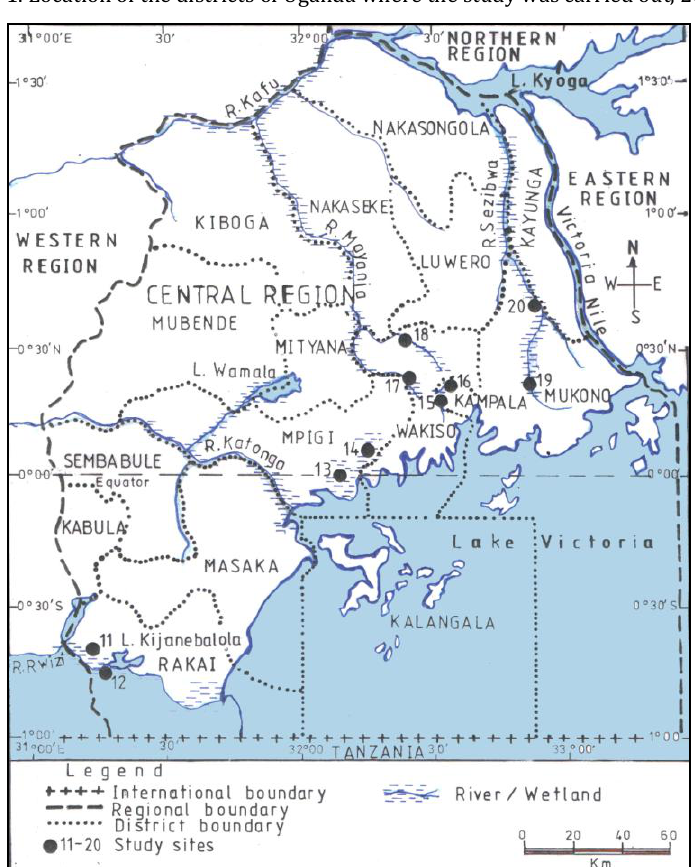
Fig. 2. Location of the study areas in the Central Region of Uganda,